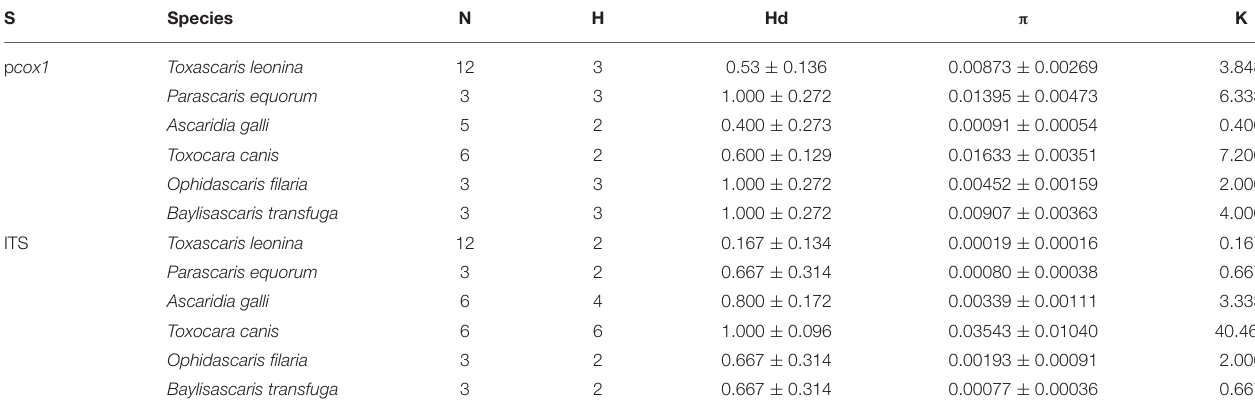
TABLE 3 | Sequence analysis of nucleotide polymorphisms by DnaSP software.